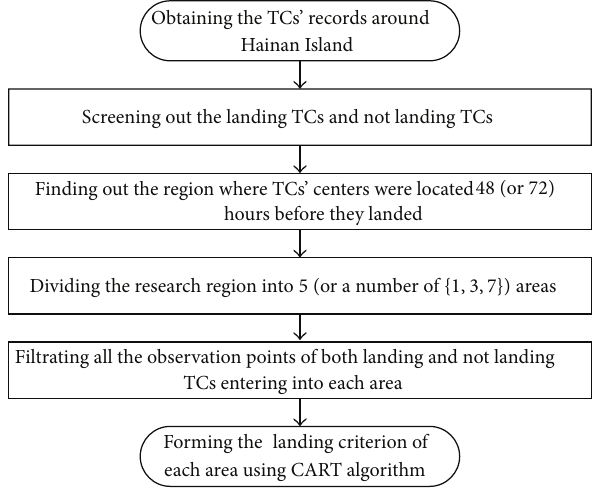
Figure 6: Flow diagram of forming landing criterions.